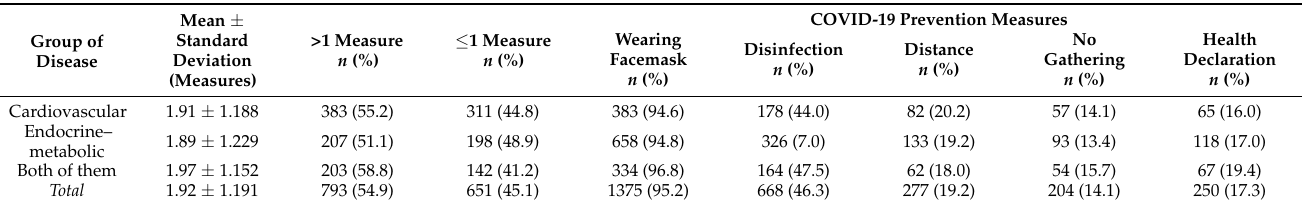
Table 4. COVID-19 prevention measures by 5 K message and the relationship between measures to prevent COVID-19 and each disease group.